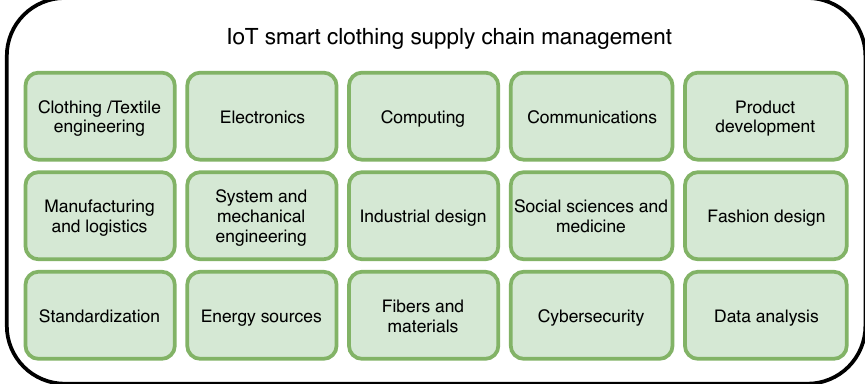
Figure 2. Disciplines involved in the IoT smart clothing supply chain